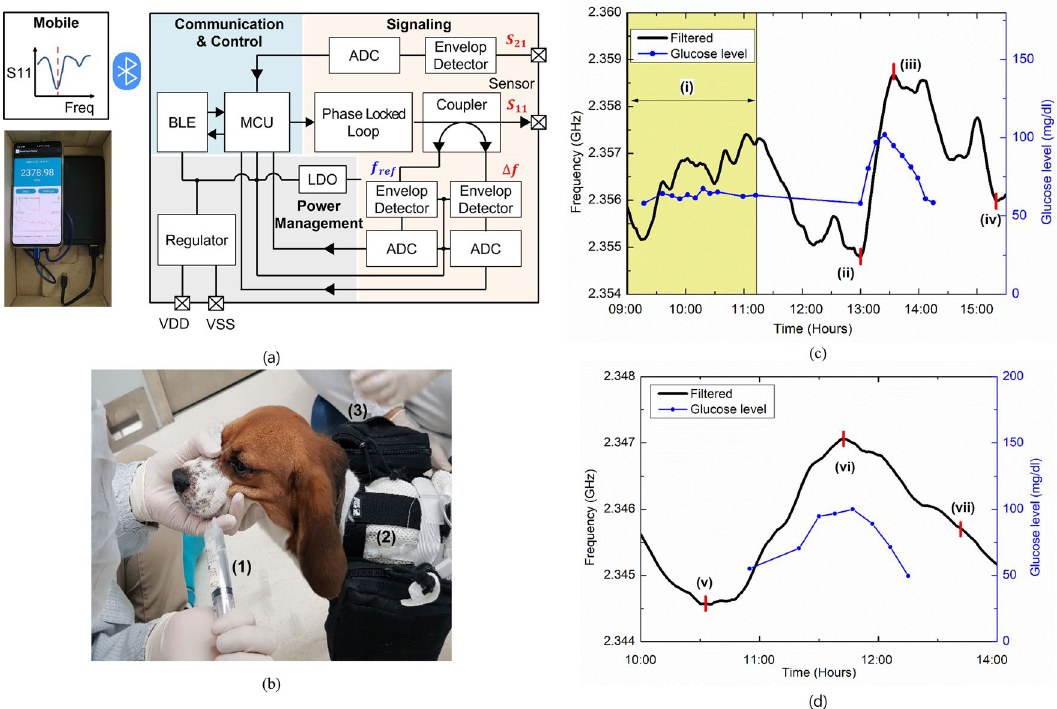
Figure 4. OGTT experiment on beagle using sensor and interface board. ( a) Proposed sensor and interface circuit board (Android app receive the sensor information using Bluetooth, MCU controller, PLL for RF generation and input to sensor); Interface board consists of three major parts: power management part (voltage regulator, LDO); RF part (PLL, wideband coupler, envelope detector); digital part (ADC, MCU). ( b ) OGTT (beagle fed with glucose solution): (1) Glucose solutions (2) Interface board (3) Battery. ( c ) Day-1 OGTT: (i) Trend of BGL and sensor frequency while feeding the beagle; (ii) first oral glucose administration; (iii) maximum BGL and corresponding sensor frequency with a time lag; (iv) sensor frequency decreases as the BGL decreases. ( d ) Day-2 OGTT (v) Second oral glucose administration; (vi) maximum BGL and corresponding sensor frequency with a time lag; (vii) sensor frequency decreases as the BGL